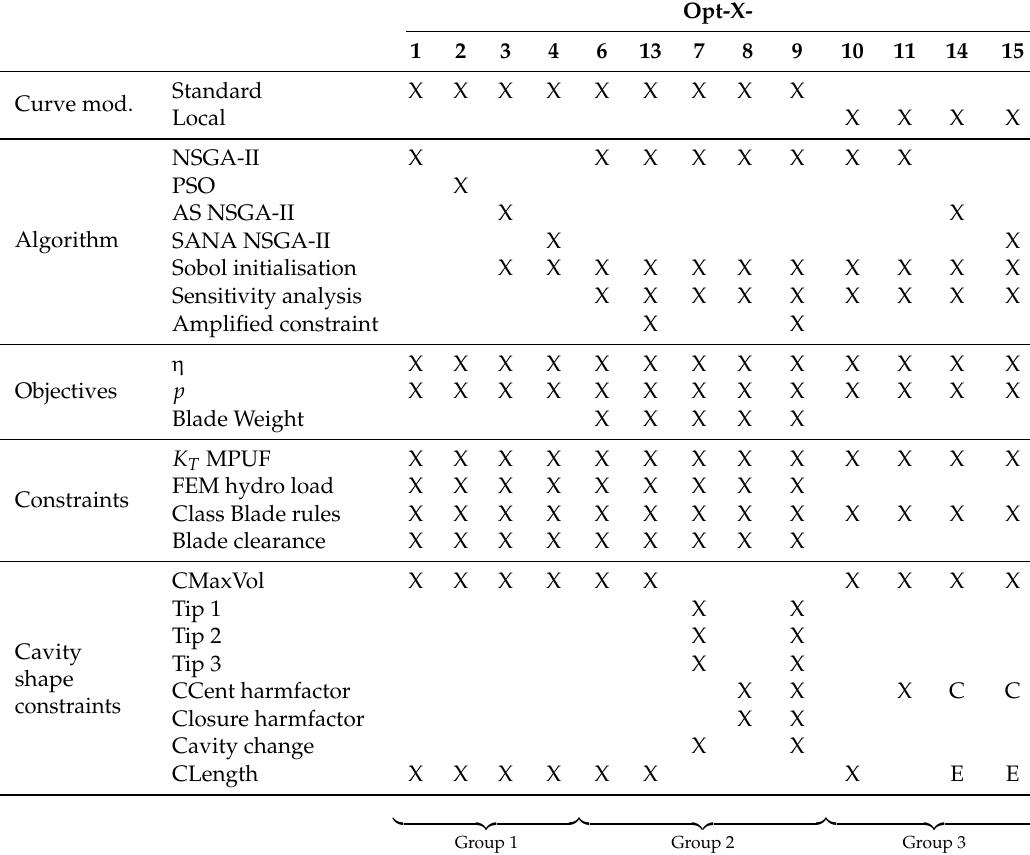
Table 4. Optimisation test matrix with alternating algorithms, geometry variation and constraint settings.